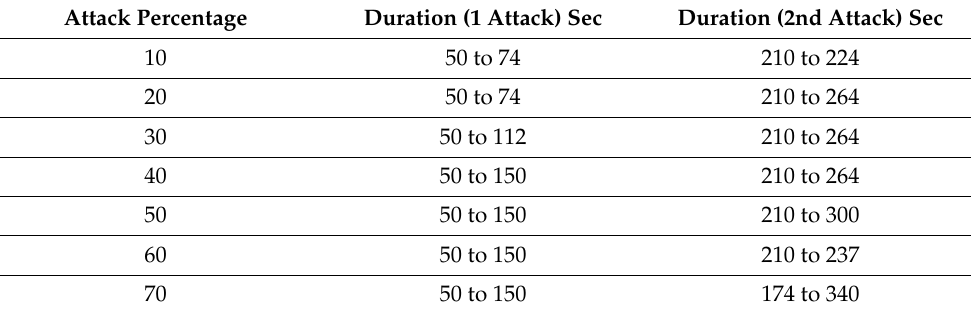
Table 3. Attacker simulation time in